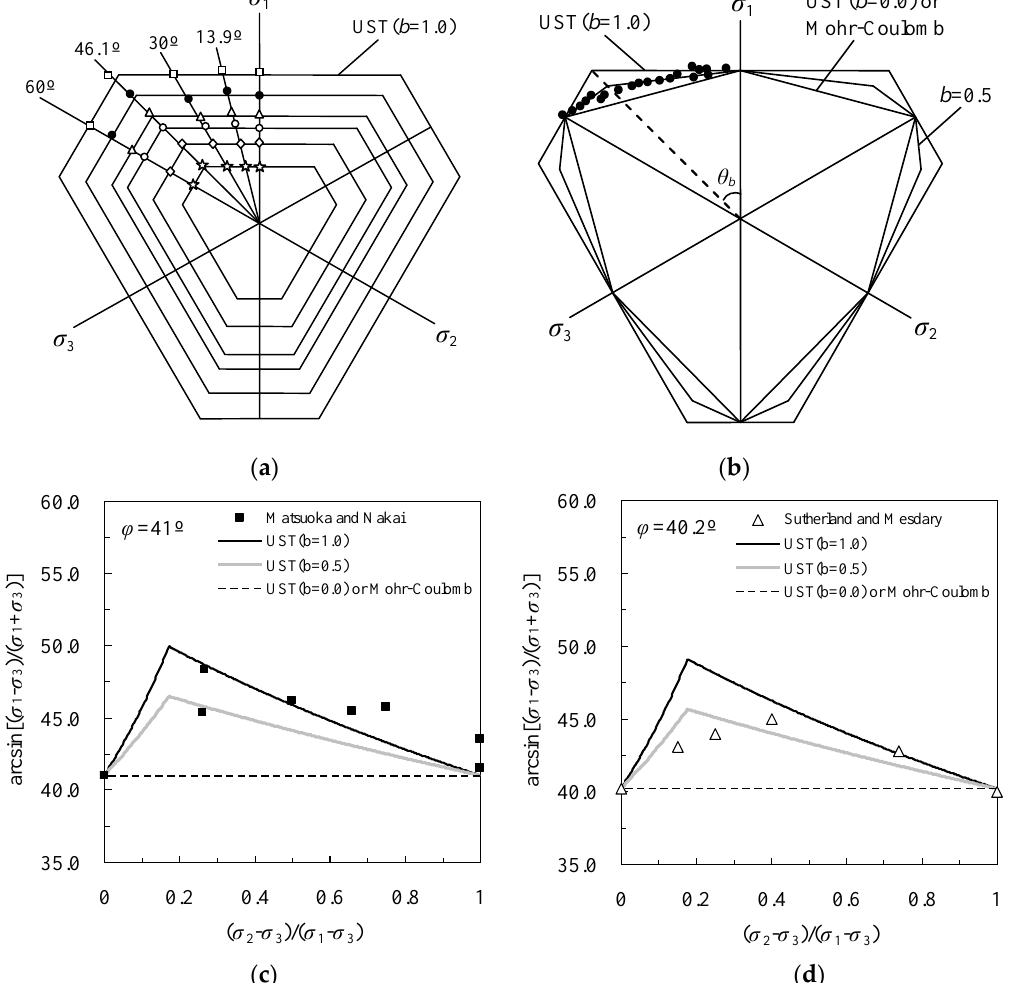
Figure 2. Limit surfaces of rock and sand under complex stress states: ( a ) Granite, ( b ) Marble, ( c ) Toyoura sand, ( d ) Loch Aline sand.